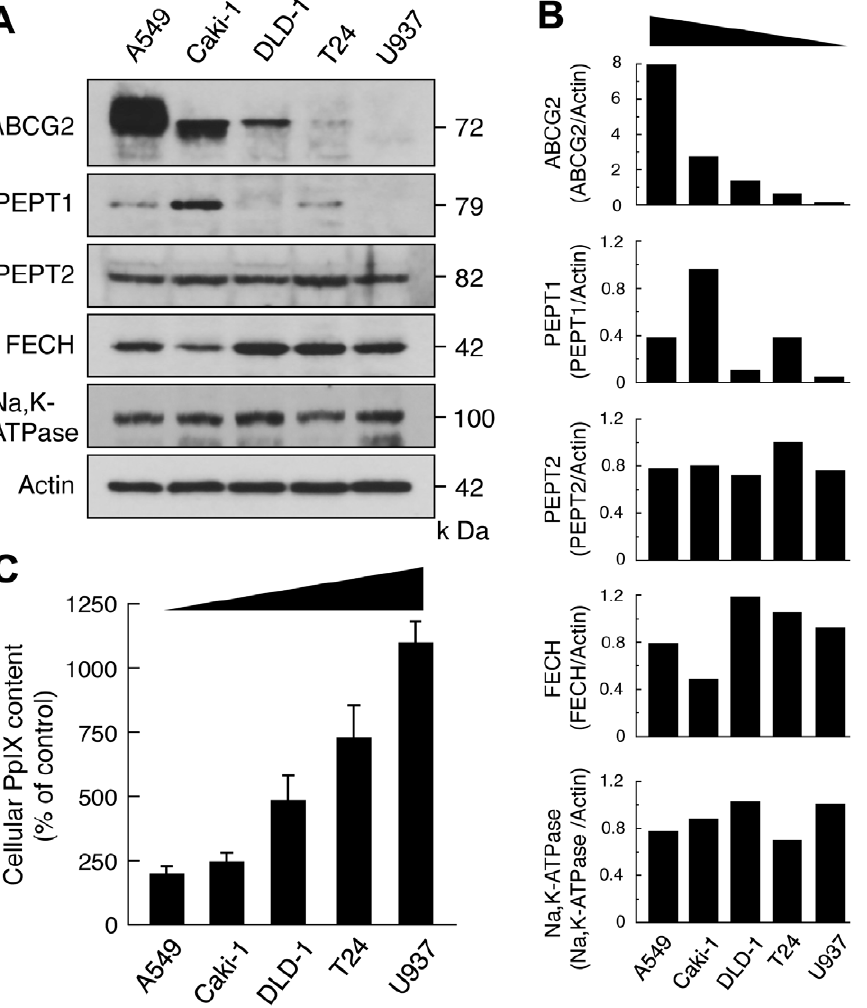
Figure 1. Expression of ABCG2, PEPT and FECH, and ALA-mediated PpIX accumulation in various cancer cells. Human lung adenocarcinoma cells (A549), human renal cancer cells (Caki-1),human colorectal cancer cells (DLD-1),human bladder cancer cells (T24) and human histiocytic lymphoma cells (U937) were used in this experiment. A, Western blotting analysis of whole cell lysates of various cancer cell lines. ABCG2 was detected with a polyclonal anti-ABCG2 (Cat. # 4477; Cell Signaling Technology). Actin was used as a protein loading control. A representative blot of multiple experiments is shown. B , Relative contents of each protein were determined by densitometric scanning and were normalized using actin. C , Levels of accumulated ALA-mediated PpIX in various cancer cell lines. Bar graphs show flow cytometric analysis results of cellular PpIX content. Mean intensities of fluorescence (autofluorescence values) obtained from control experiments of each cell line were normalized to 100%. Results represent the mean 6 SD of three independent